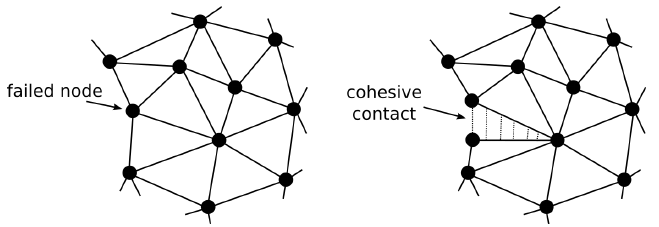
Figure 6. Principle of cohesive contact